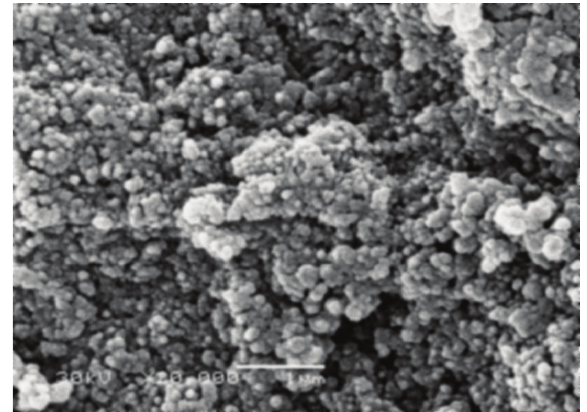
Figure3:SEMimageofpreparednanozirconiumtungestovanadate.